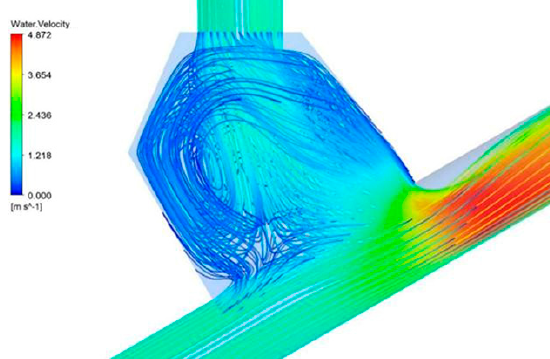
Figure 11. The velocity distributions of particles and fluid under Case 3.